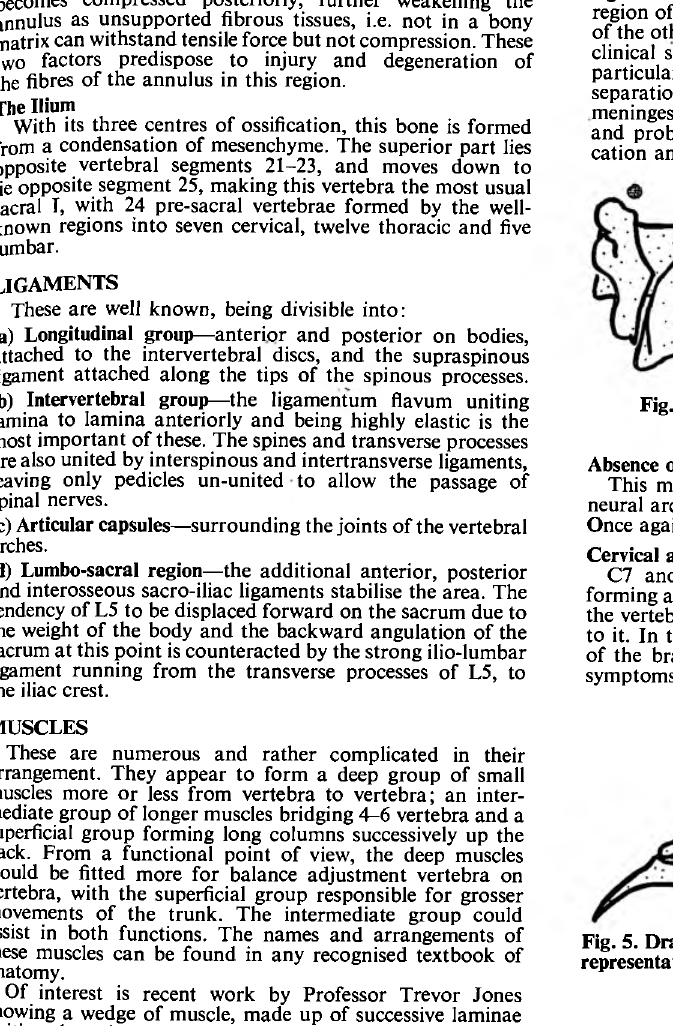
Fig. 5. Drawing from specimen of cervical rib and diagramatic representation of kinking of subclavian artery and brachial plexus by the